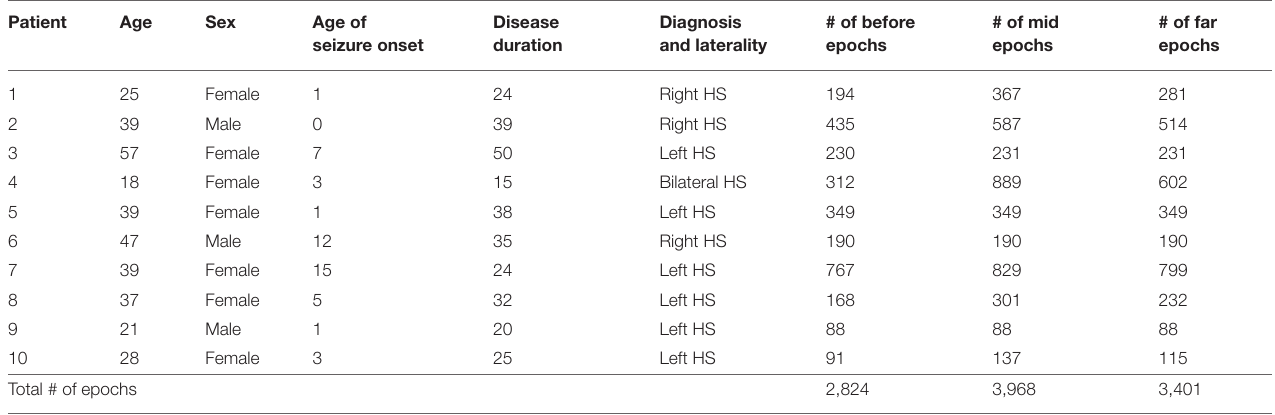
TABLE 1 | Clinical data and number of epochs for subjects that participated in the study.